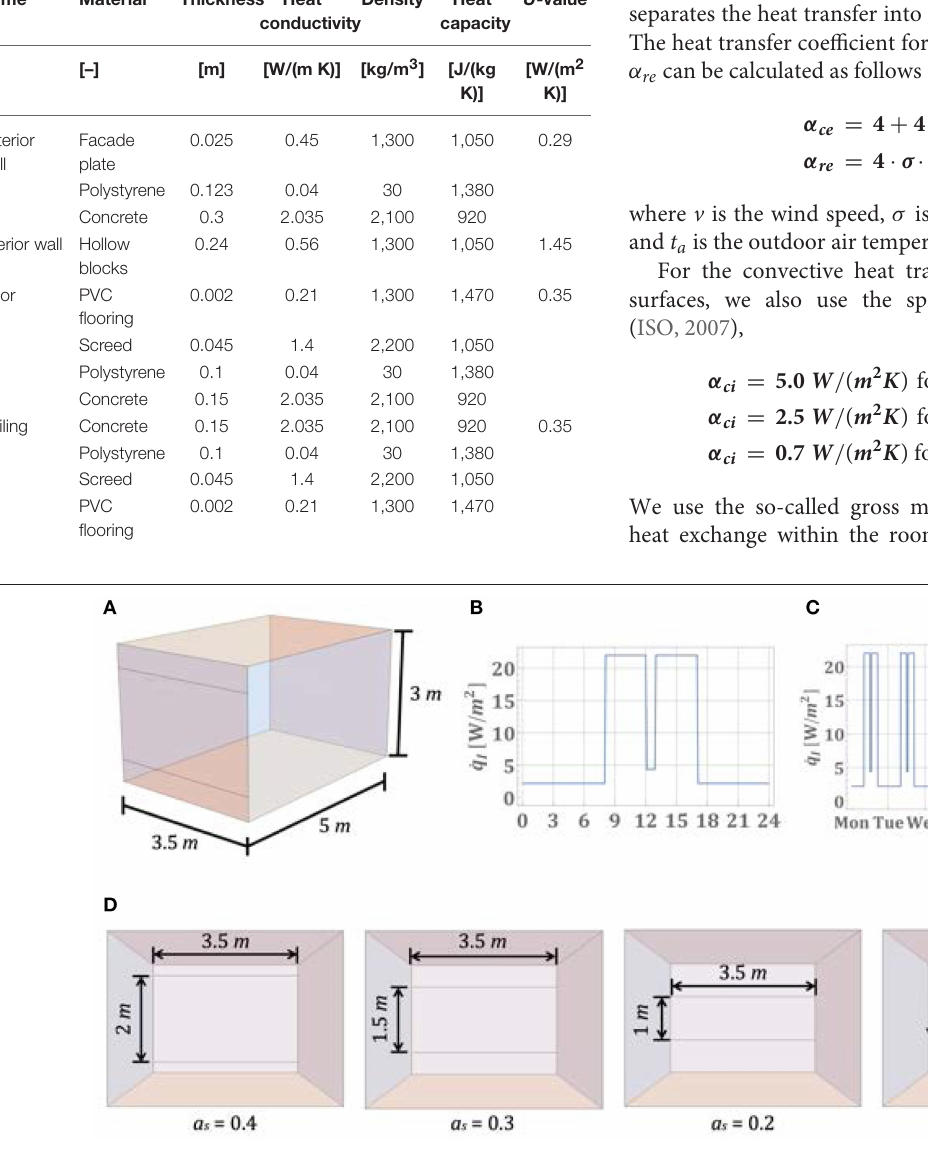
FIGURE 5 | (A) Geometry of the test room with an area ratio of 0.4. (B,C) Time-dependent internal heat gain for simulating a highly-occupied office. (D) Different glazing geometries and size factors.